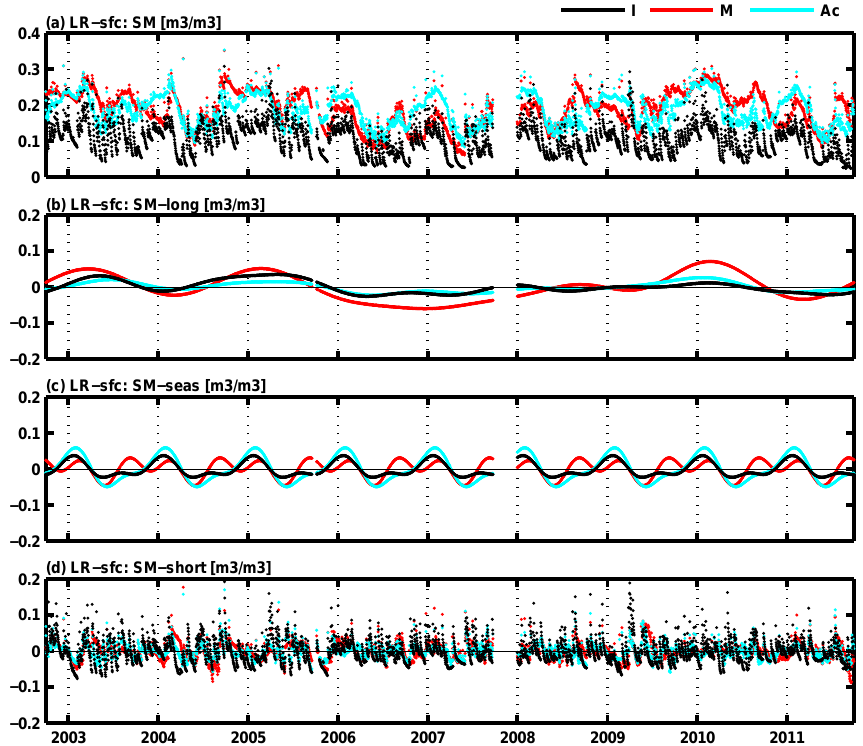
Figure 6. Harmonic decomposition of the ARS in situ (I), Catchment model (M), and baseline assimilation output (Ac) near-surface soil moisture time series at Little River, showing the (a) original time series, (b) SM long , (c) SM seas , and (d) SM short